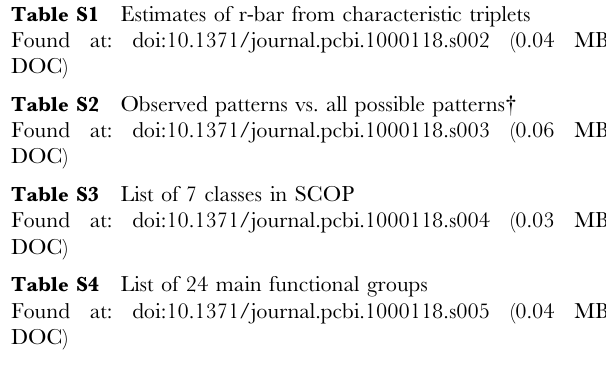
DOC) Table S6 Numbers of protein